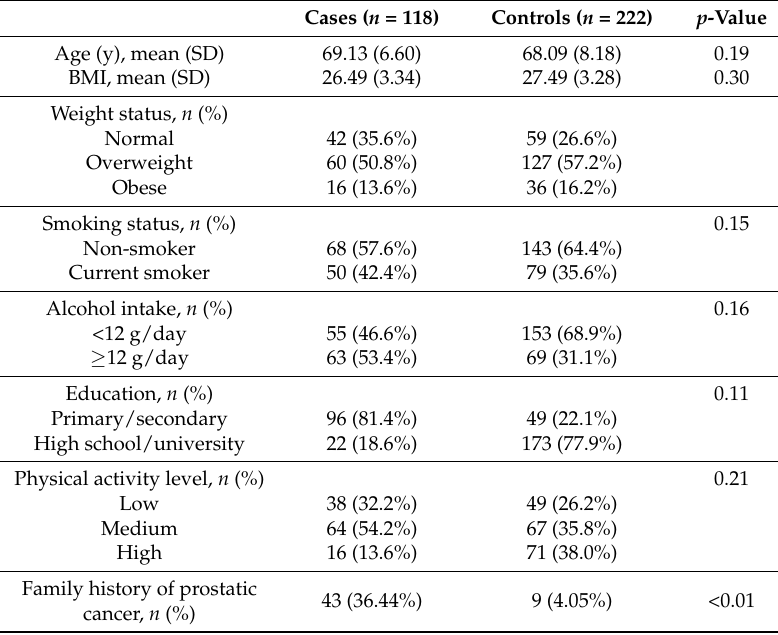
Table 1. Baseline characteristics of cases and